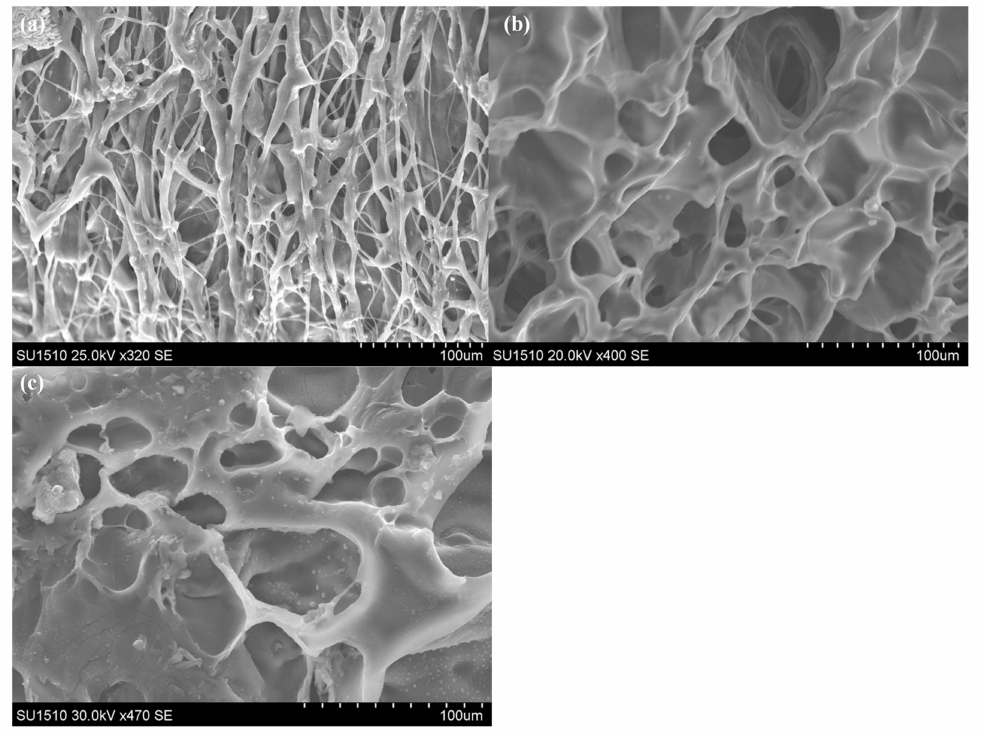
Figure 10. Micrographs of G series, section view, after 193 days of degradation: ( a ) G4, ( b ) G8, and ( c )